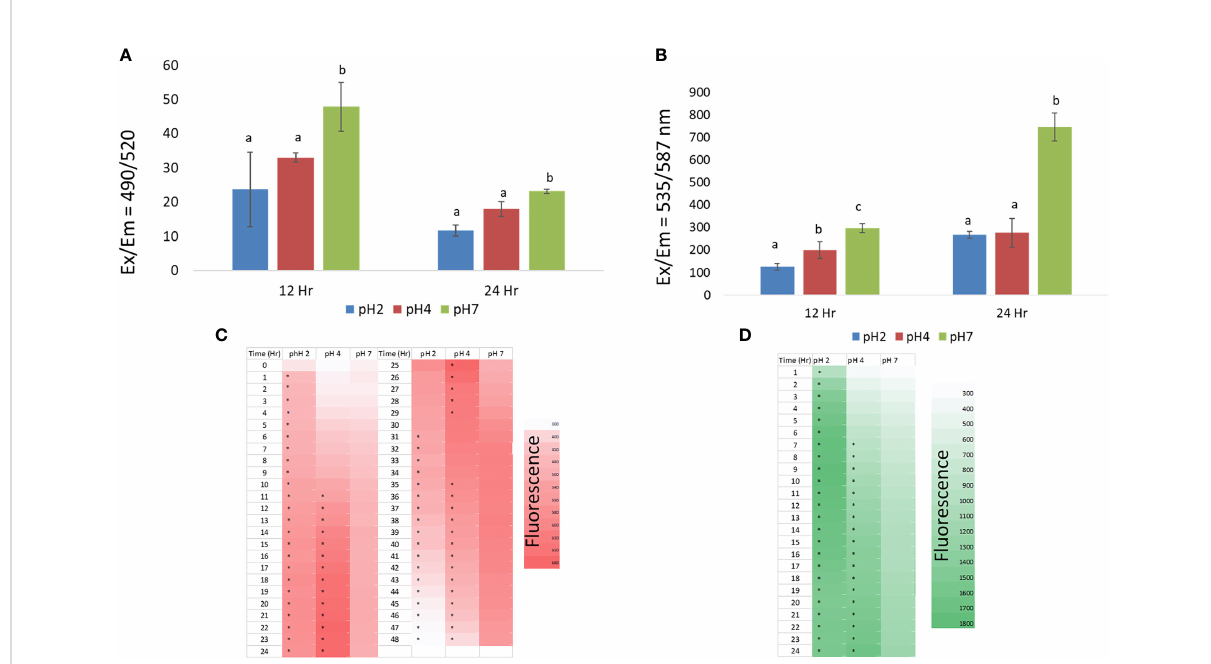
FIGURE 2 (A) the effect of pH 2, 4, and 7 culture media on J774A.1 macrophage phagocytotic activity; (B) the effect of pH 2, 4, and 7 culture media on J774A.1 macrophage ATP production; (C) ROS production in pH 2, 4, and 7 microenvironments, from 1 h to 48 h; (D) Changes in intracellular Ca 2+ production in pH 2, 4, and 7 microenvironments, over a 1 h to 24 h time period. Representative data are expressed as the mean ± SEM; (A – C) means with signi fi cant change (p < 0.05). The a, b, c means with a signi fi cant difference through the Scheffe and one-way ANOVA